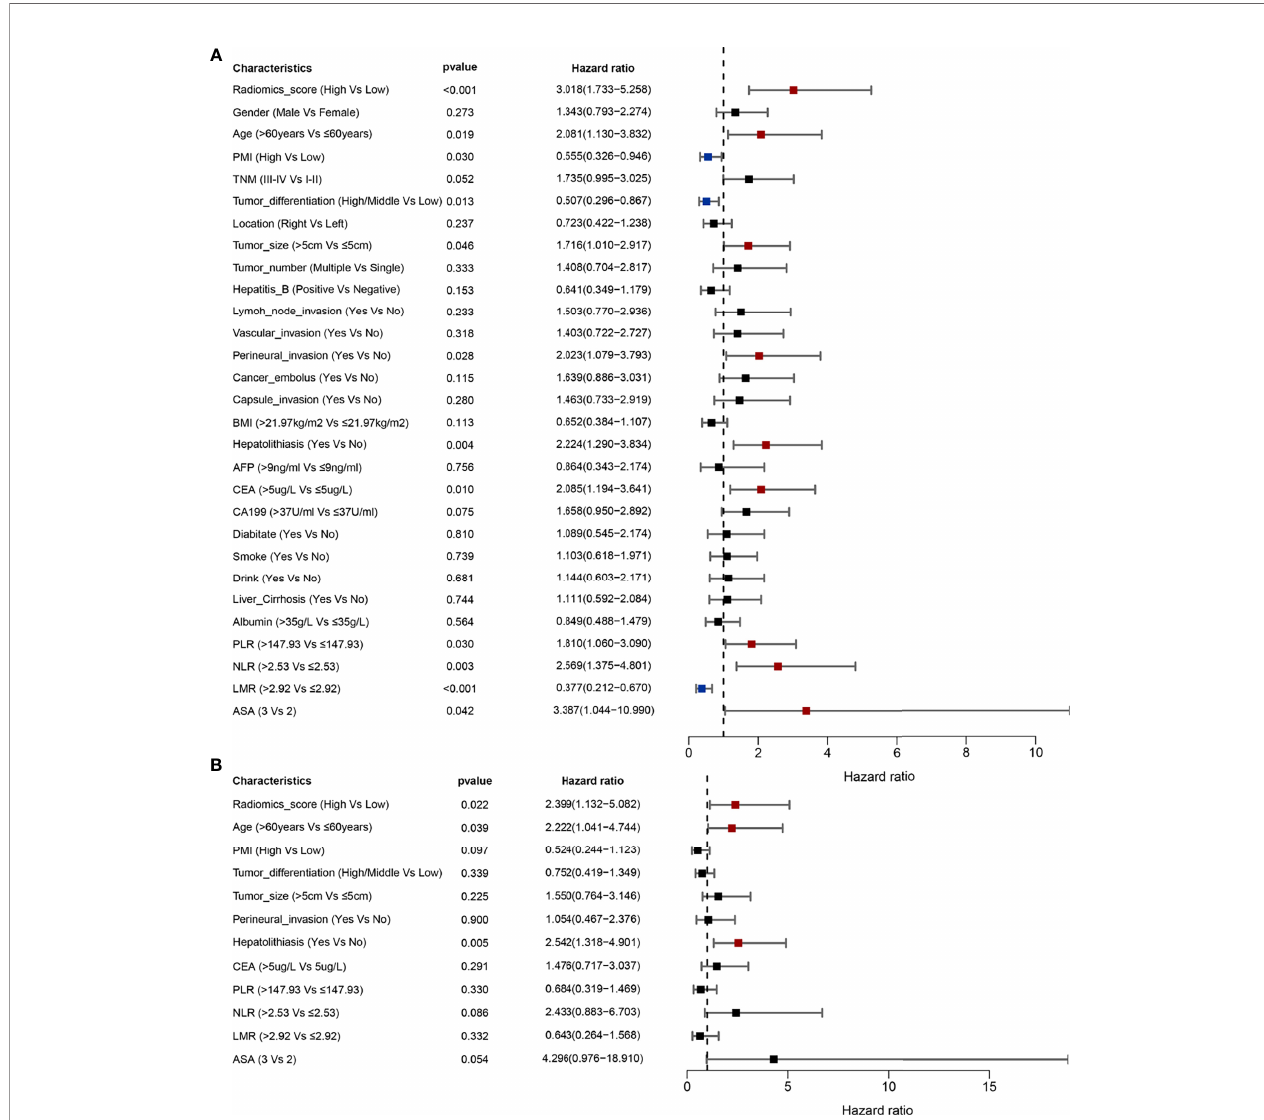
FIGURE 5 | Prognostic factors of RFS identi fi ed by univariable and multivariable Cox regression analyses. (A) Univariable analyses identi fi ed the factors of RFS ( p < 0.05). (B) Multivariable analyses identi fi ed the factors of RFS ( p <